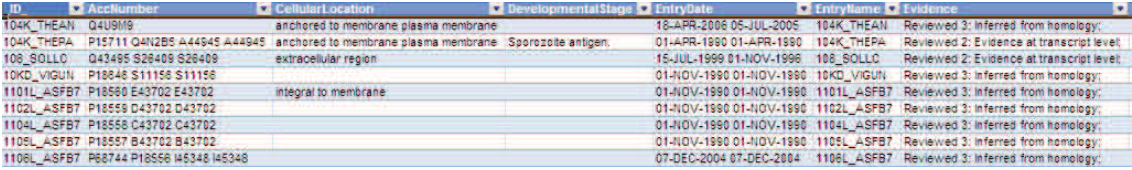
Figure 3: Database import format for LAILAPS – the Excel-screenshot shows a snapshot of a CSV-formatted SWISSPROT export. Each row represents one database entry. The columns are the fields. The first row contains all field